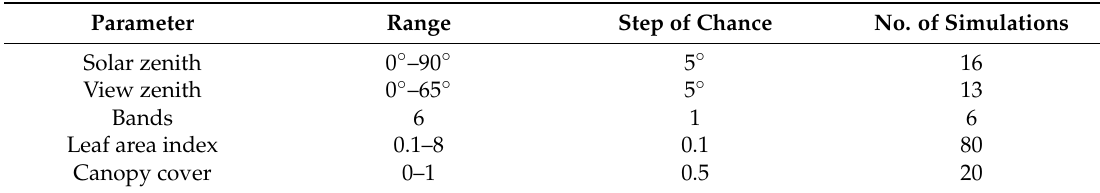
Table 3. Parameters of the look up table in LAI